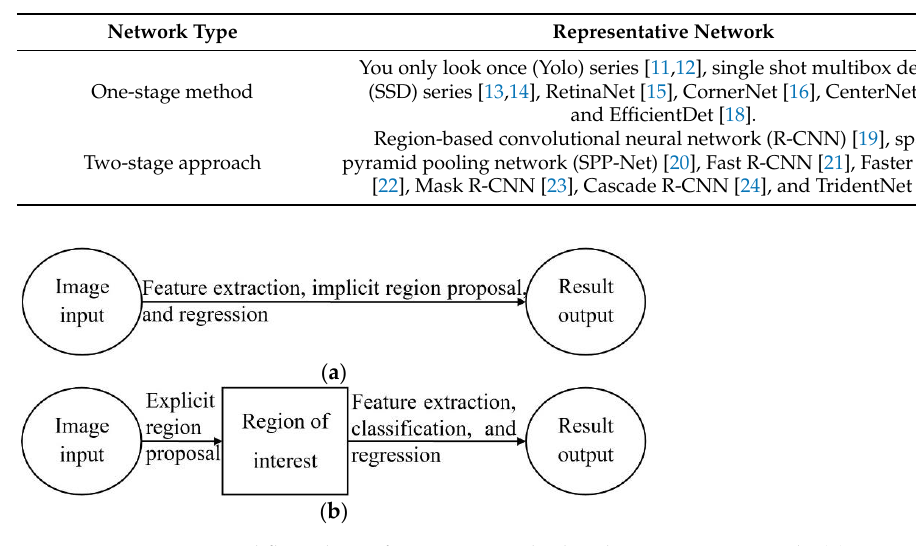
Figure 1. Computational flow chart of one-stage method and two-stage approach. ( a ) Computational flow chart of one-stage method. ( b ) Computational flow chart of two-stage approach.